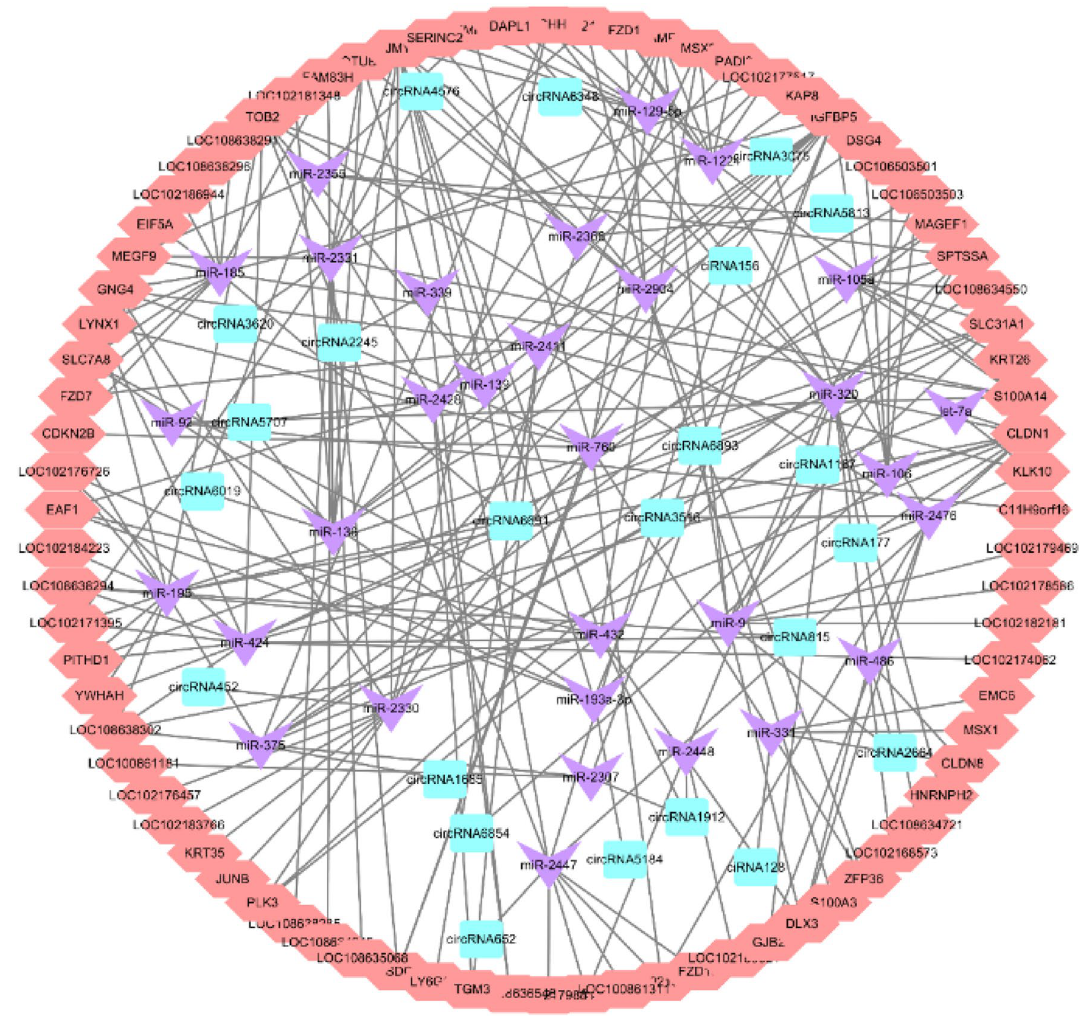
Figure 8. Regulation network of circRNA–miRNA–mRNA. Pink: mRNAs, blue: circRNAs, purple: